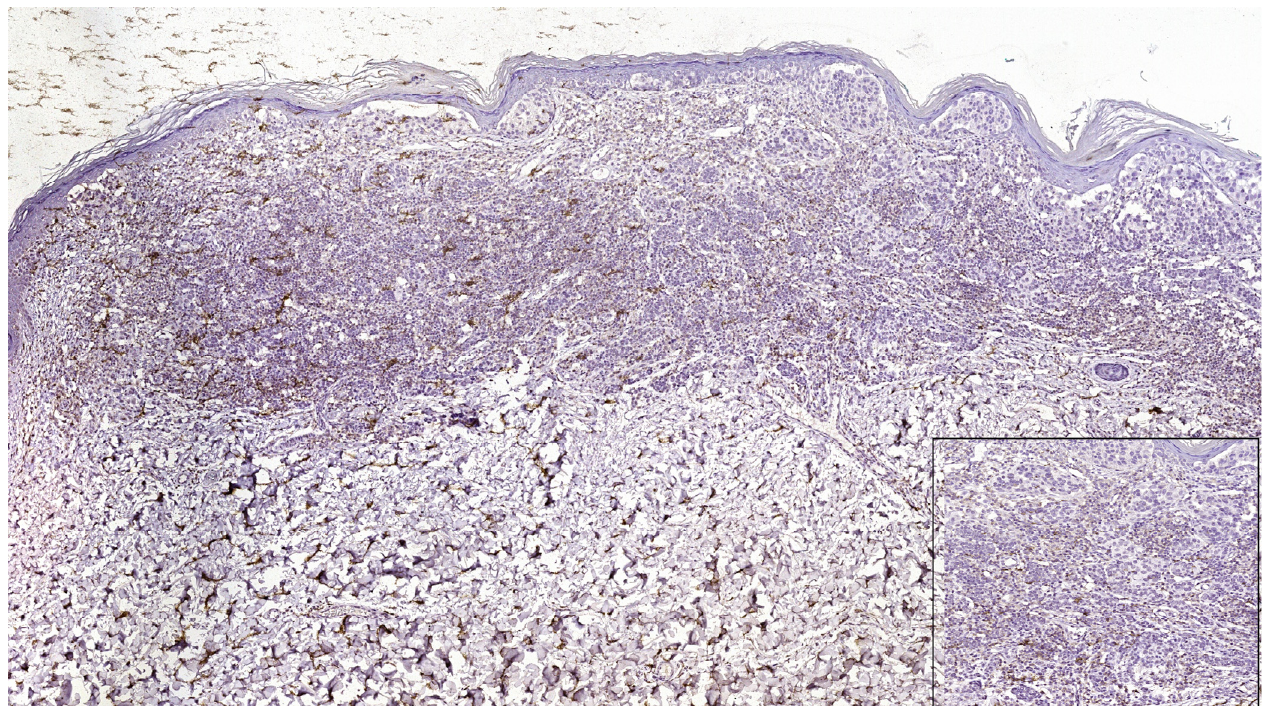
Figure 5. PD ‐ L1 negative expression in tumor cells and focally positive in TILs in a case of superficial spreading melanoma (PD ‐ L1 Monoclonal Antibody, Clone CAL10). Lower right side, detail, ob.x400. Although PD-L1 expression associated with no TILs was not observed in melanoma tumor cells (X 2 = 2.775, p = 0.514), PD-L1 was expressed in T lymphocytes (X 2 =